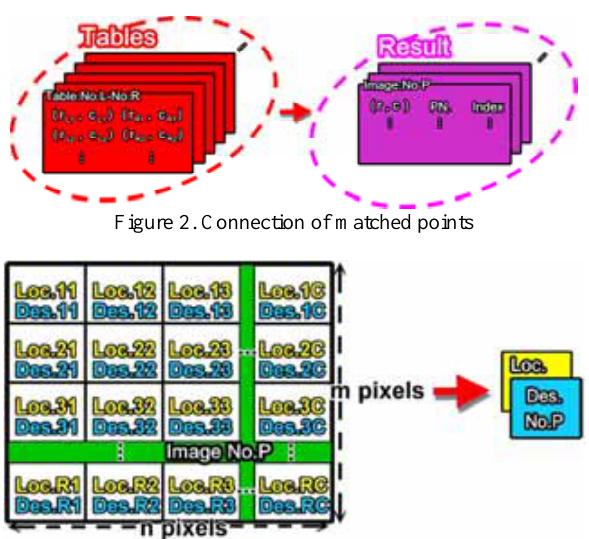
Figure 3. Method of key point extraction for a large image